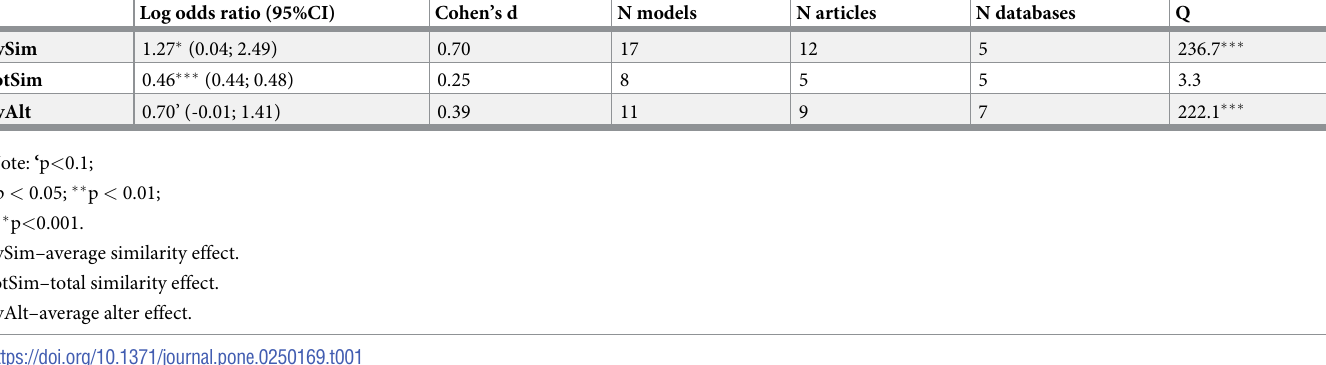
Table 1. Effect size estimates for peer influence effects. Log odds ratio